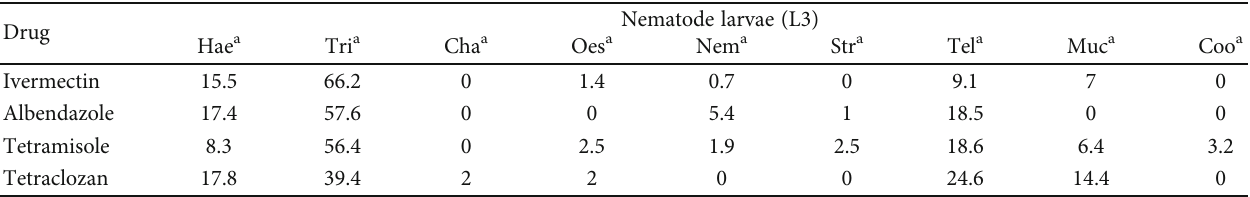
Table 2: Percentage of nematode infective larvae identi fi ed based on the morphology of larvae (L3) from coproculture before administration of anthelmintic drugs.